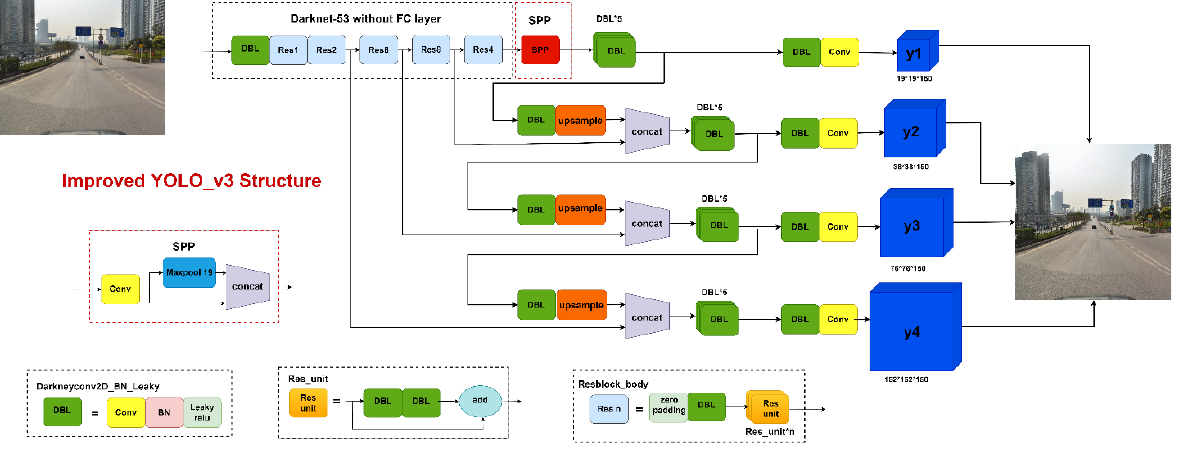
Figure 6. Structure of the improved YOLOv3 network.